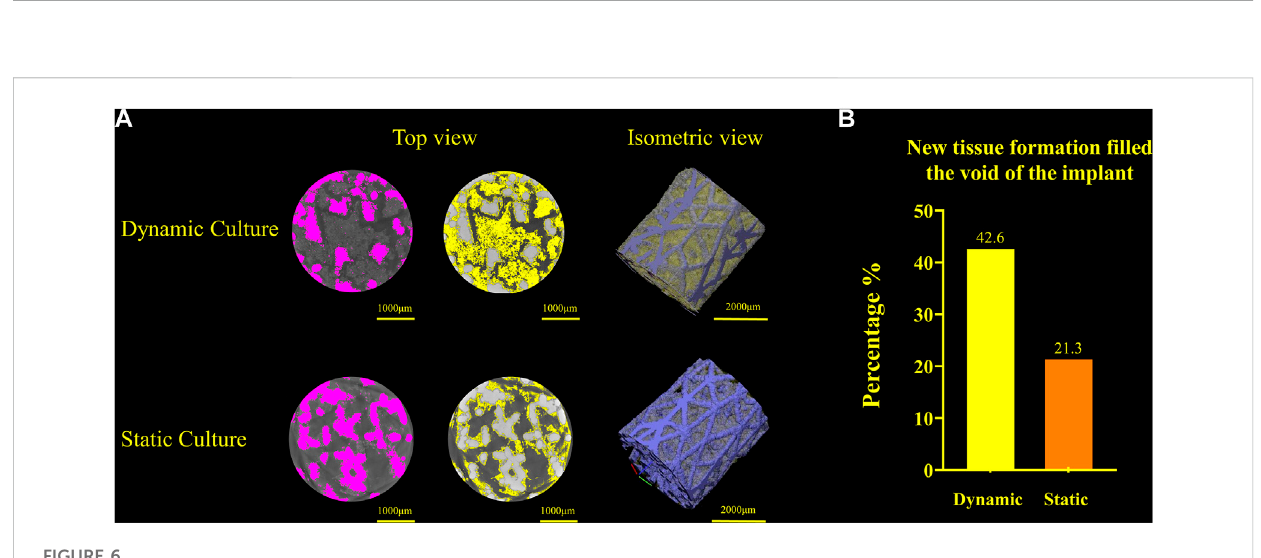
FIGURE 6 (A) Titanium implant micro-CT scans and 3D volume renderings for the dynamic culture (top) and the static culture (bottom) showing the segmentedimplant(pink,left),tissue(yellow,middle)and3Drender(titaniumblue,tissueyellow,right). (B) Twiceasmuchtissuevolume,asapercentage of the void space, was detected for the dynamic culture